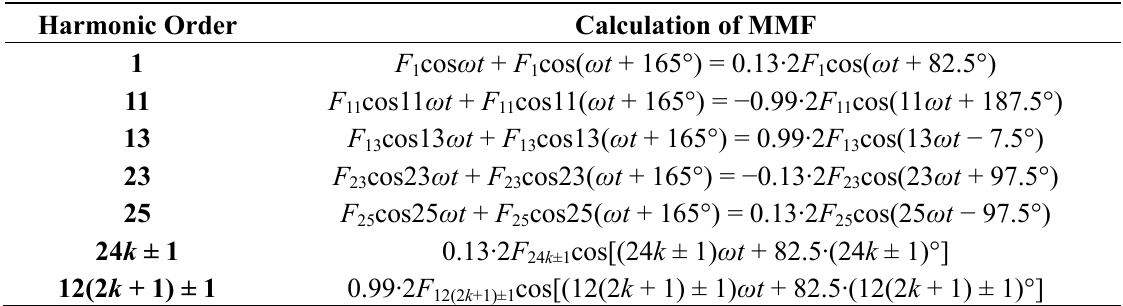
Table 2. Derivation of air-gap MMF for all-teeth-wound